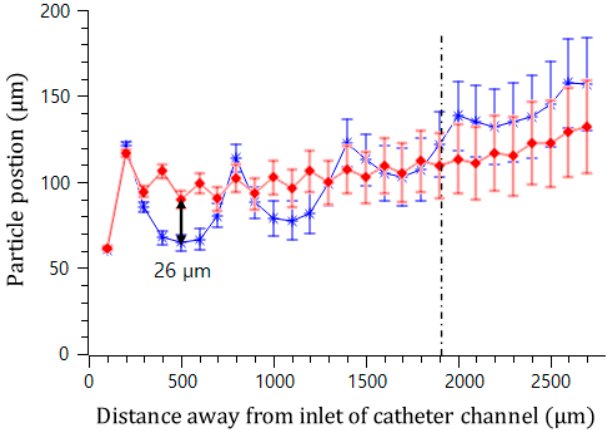
Figure 8. Trajectory of microsphere movement in the bubble catheter channel with the interval lengths of 100 μ m (red diamond) and 500 μ m (blue asterisk).